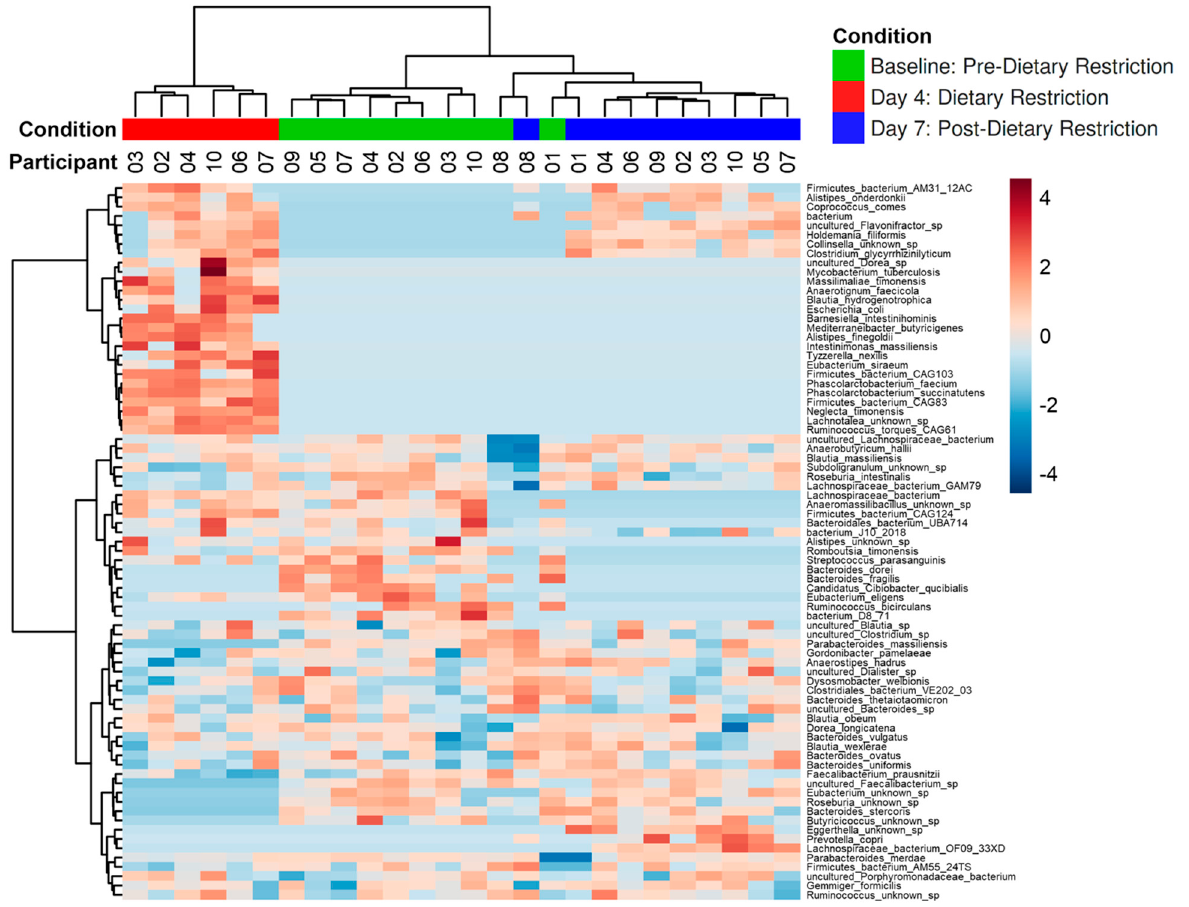
Figure 5. Heatmap of significantly different species (FDR p < 0.05). A total of 77 species were found to have differences between conditions (FDR p < 0.05). Species grouped well by condition. Most species present at Baseline decreased in abundance on Day-4 and trended toward baseline levels by Day-7. Several species were unique to the Day-4 condition.